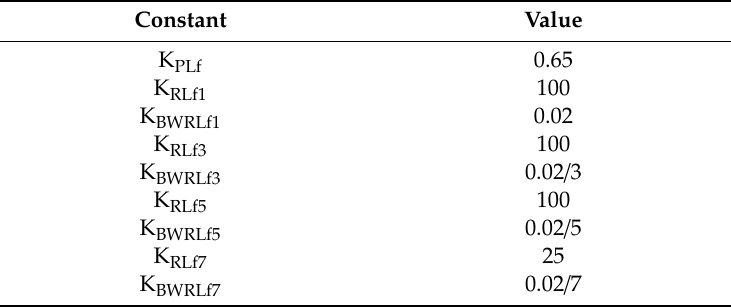
Table 3. Constants of the regulator P + R +